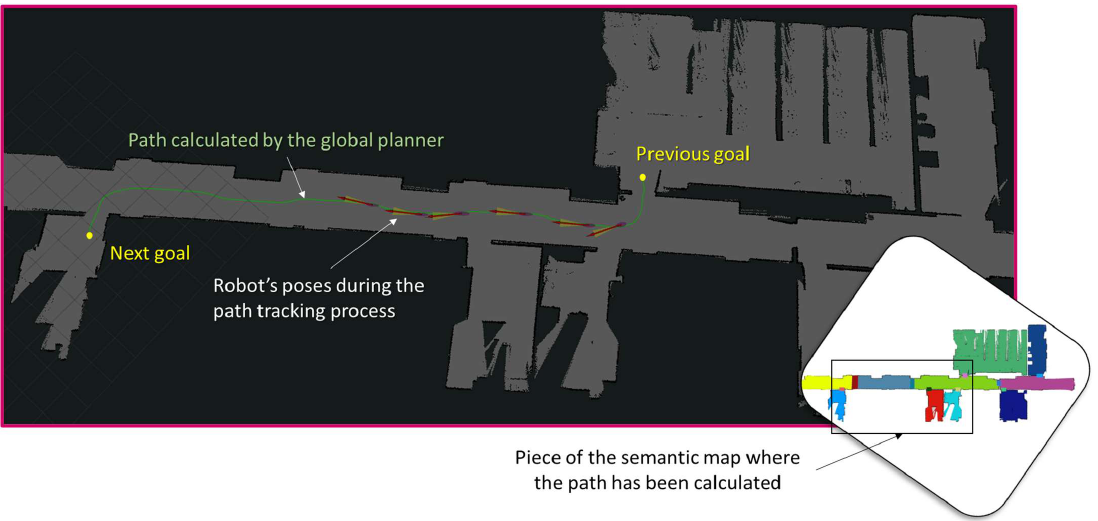
Figure 6 . Experiment in the laboratory with a real robot ( rviz -based view). The path is calculated between two navigation goals, corresponding to two different regions in the semantic path, by the global planner. Arrows represent the different poses of the robot when it is tracking the global path.